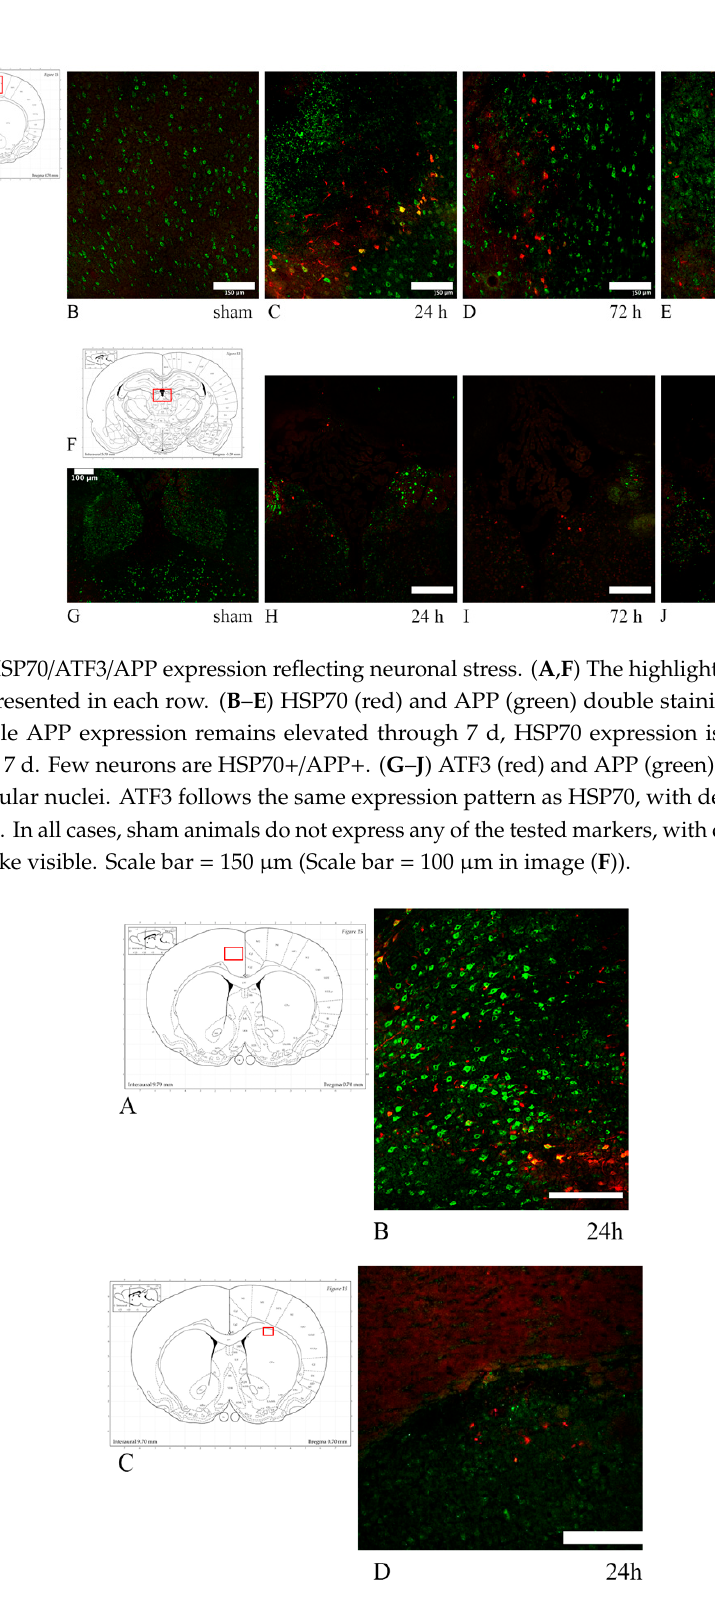
Figure 13. HSP70 / APP double-staining in 24 h trauma-exposed animals. ( A , C ) The highlighted area refers to the area represented in the adjacent microphotograph. ( B ) HSP70 and APP expression in the cingulate cortex. Few neurons are positive for both markers. ( D ) HSP70 and APP expression in the caudoputamen, close to its interface with the corpus callosum. Scale bar = 200 µ m.